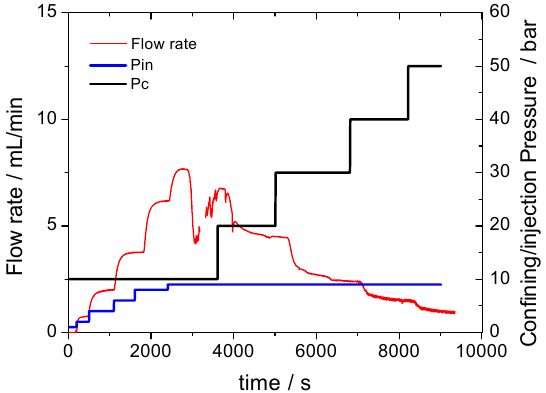
Figure 11. Gas-injection pressure (Pin) versus time and evolutive confinement pressure (p c ) vs out-flow rate.